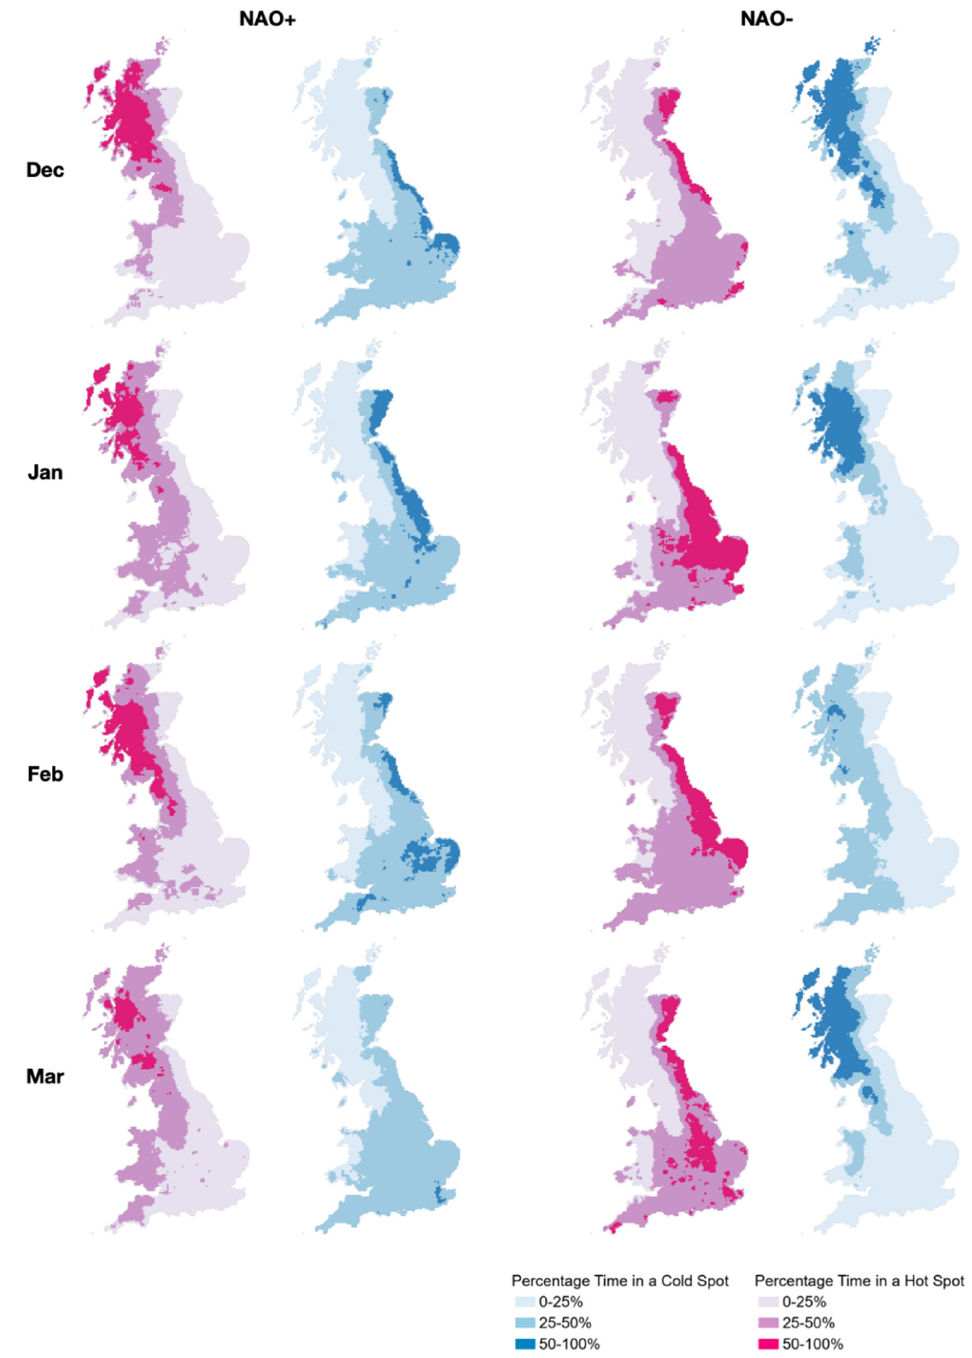
Figure A1. Disaggregated space-time hot spot results (DJFM). Values indicate percentage of time in a statistically significant hot/cold spot.